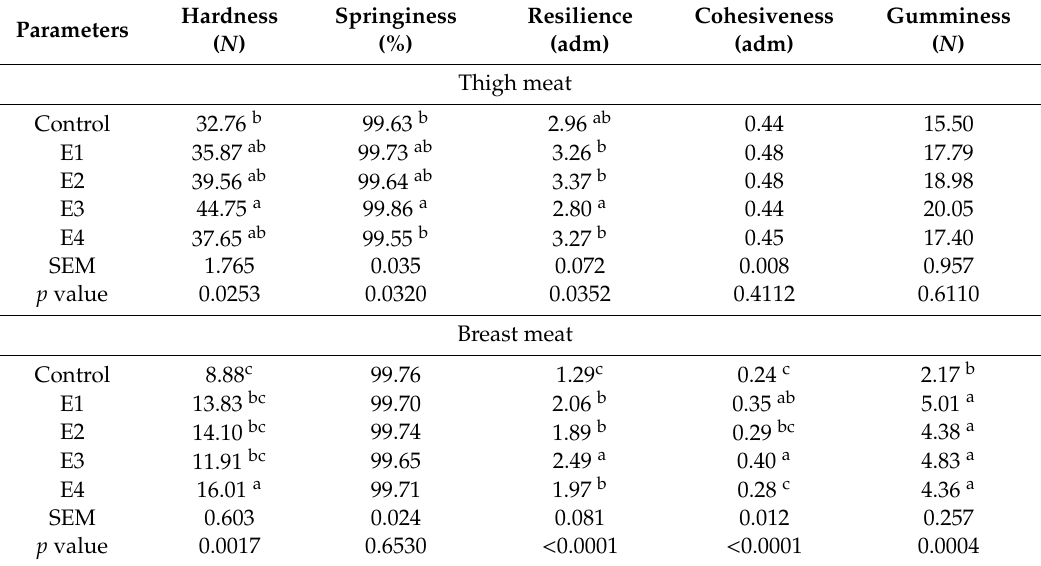
Table 4. Texture parameters of chicken meat determined by double-cycle